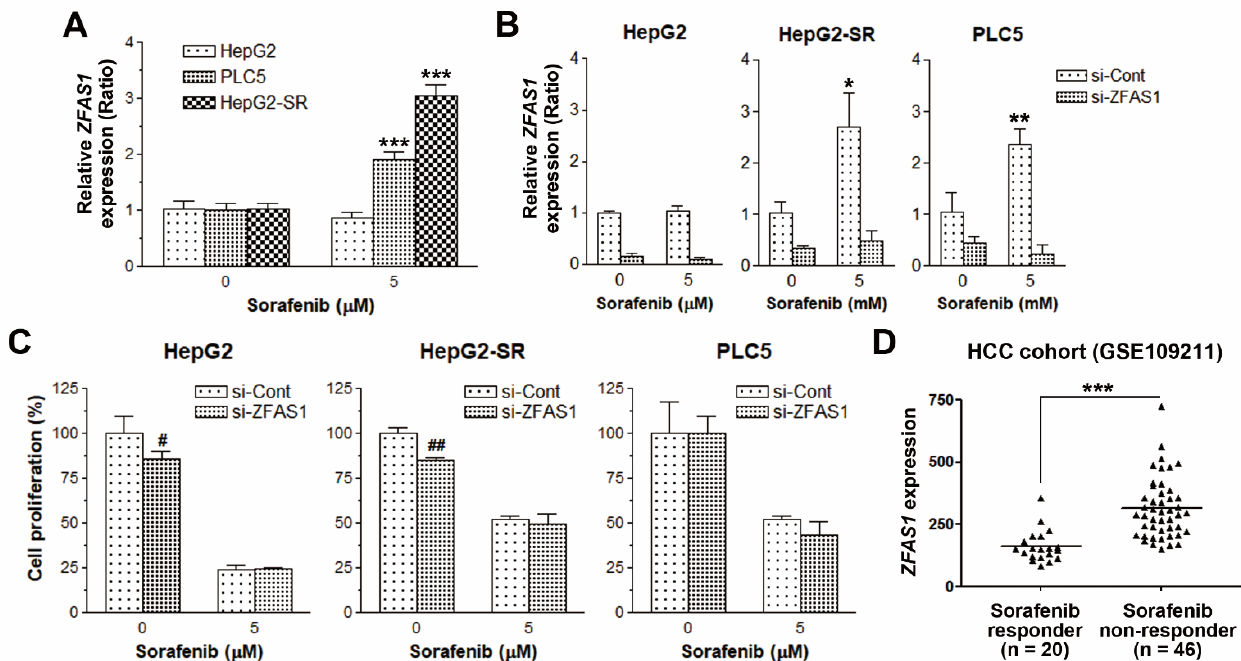
Figure 4. The effect of ZFAS1 knockdown on sorafenib resistance in HCC cells. ( A ) HepG2, HepG2-SR, and PLC5 cells were treated with 5 μM sorafenib for 18 h, and then ZFAS1 expression was analyzed by real-time qPCR. *** p < 0.001 indicated the statistically significant difference between sorafenib-treated and untreated cells. ( B , C ) HepG2, HepG2-SR, and PLC5 cells were transfected with si-ZFAS1 or its negative control siRNA (si-Cont) for 24 h, and then ZFAS1 expression was analyzed by real-time qPCR ( B ). The transfected cells were treated with 5 μM sorafenib for 48 h. The cell proliferation was examined by BrdU incorporation assay ( C ). * p < 0.05 and ** p < 0.01 indicated the statistically significant difference between sorafenib-treated and untreated cells. # p < 0.05 and ## p < 0.01 indicated the statistically significant difference between si-Cont and si-ZFAS1-transfected cells. ( D ) The ZFAS1 mRNA expression levels in sorafenib responsive and non-responsive HCC patients were obtained from the microarray data set (GSE109211). *** p < 0.001 indicated the statistically significant difference between sorafenib responders and non-responders.